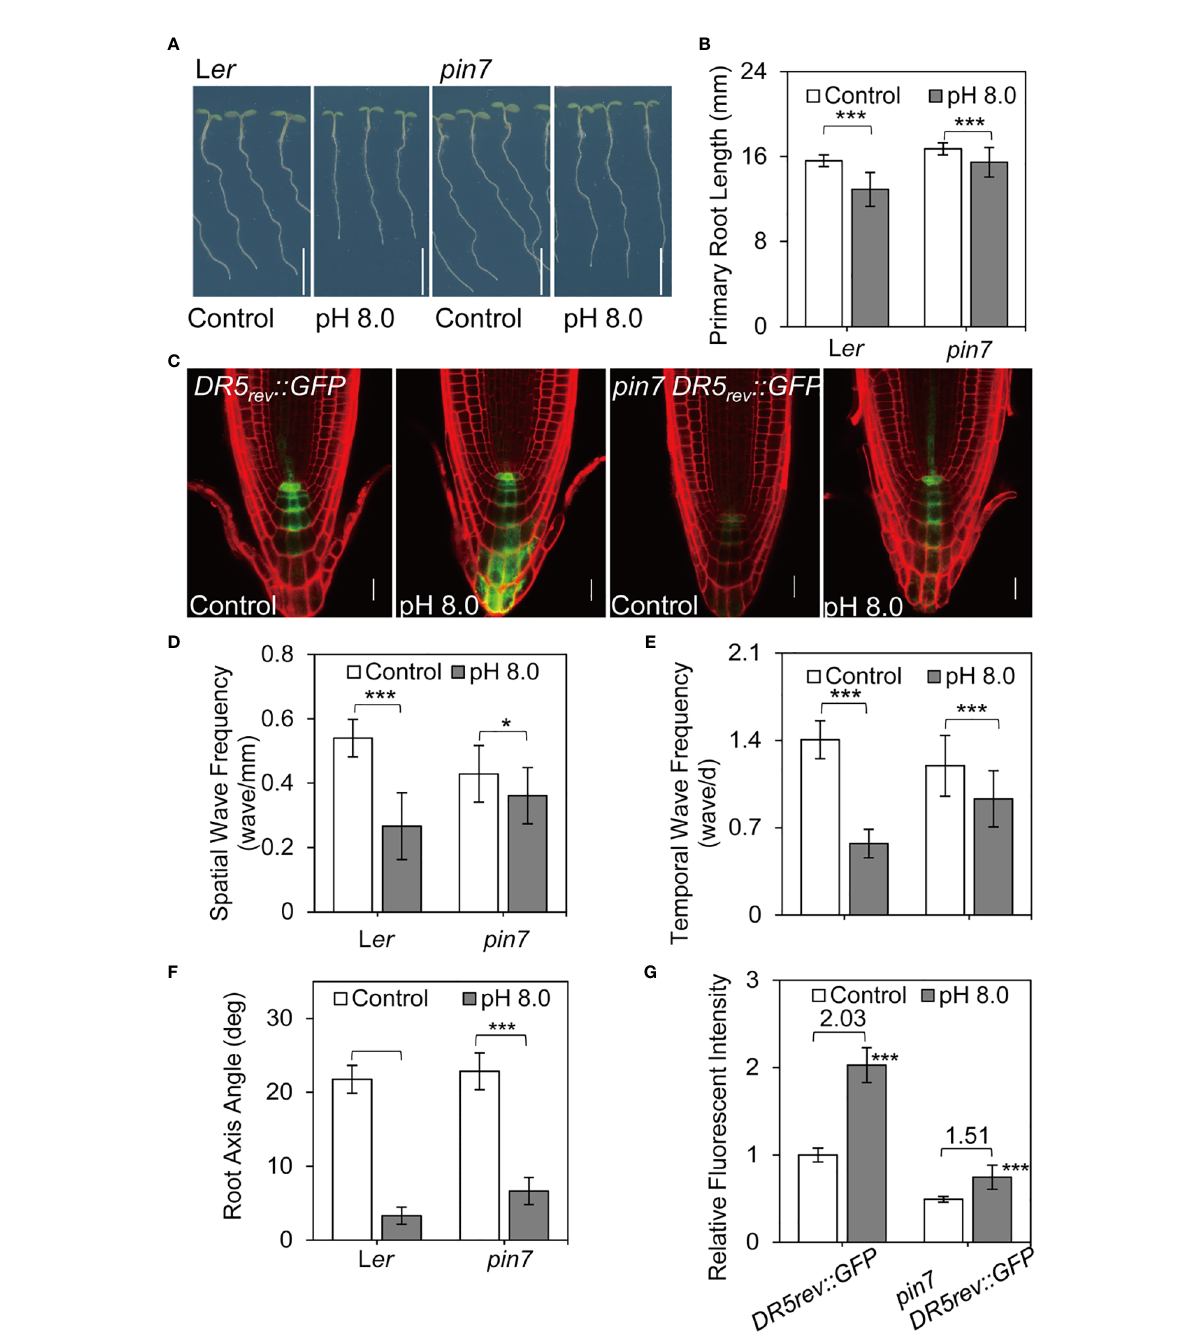
FIGURE 4 PIN7 plays a crucial role in auxin accumulation and root waving phenotype under alkaline stress. (A) The root phenotype of 6-d-old wild-type seedlings and pin7 mutants under control (pH 5.8) or alkaline (pH 8.0) conditions. Scale bar, 5 mm; (B) Quanti fi cation of the primary root length as demonstrated in (A) Values are mean ± SD (n > 40 seedlings). (C) Auxin distribution pattern as revealed by the DR5rev::GFP reporter in wildtype seedlings and pin7 mutants under control (pH 5.8) or alkaline (pH 8.0) conditions. (D, E, F) Statistical analysis of the spatial wave frequency (wave/mm) (D) , temporal wave frequency (waves/d) (E) , and root axis angle (F) in wild-type seedlings and pin7 mutants as shown in (A) (n > 40 seedlings). (G) Relative auxin level as revealed by the DR5rev::GFP reporter in wild-type and pin7 mutants as shown in (C) (n > 15). Statistically signi fi cant differences were determined by using student ’ s t-test (* P < 0.05; *** P <